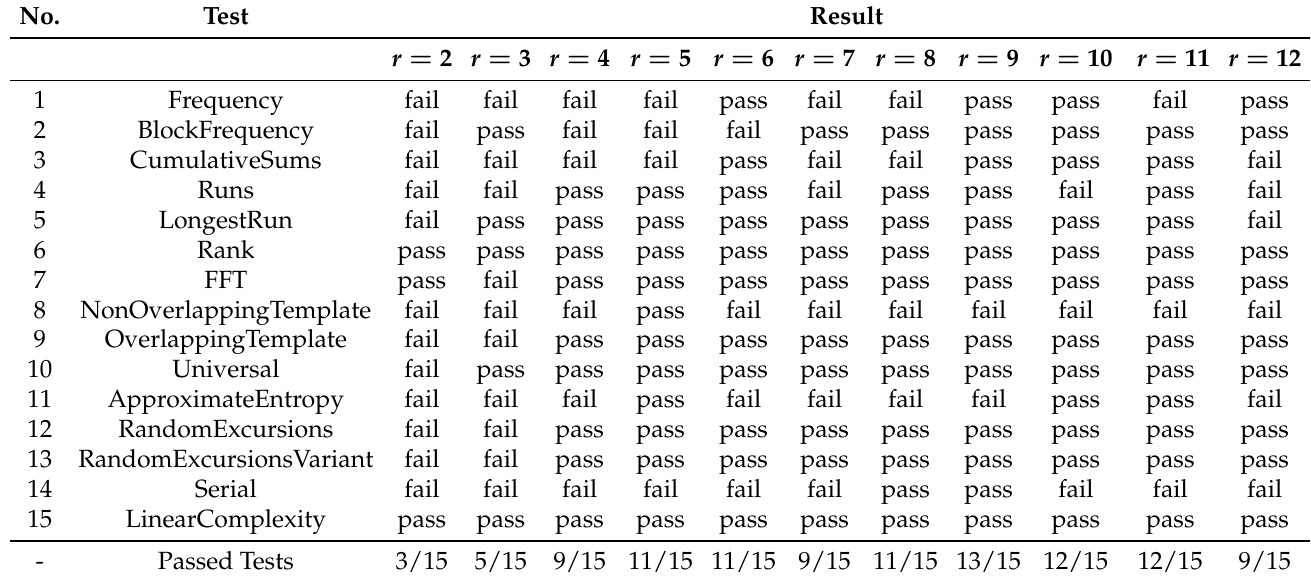
Table A3. NIST test results for (33) using map (26) ( x 0 = 0.1, k = 10).